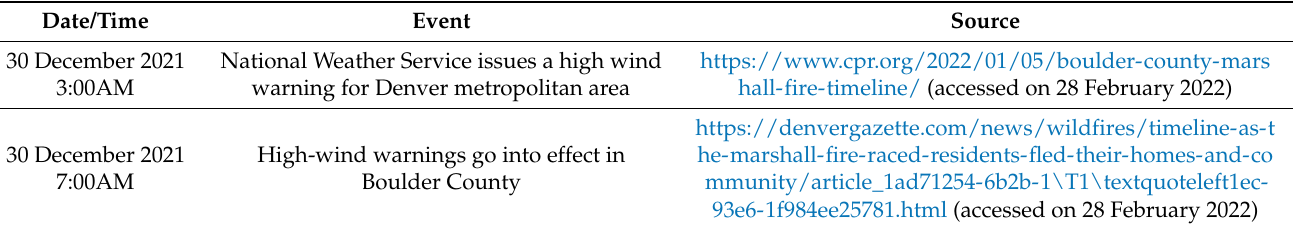
Table A1. Timeline of the Marshall Fire, 30 December 2021–1 January